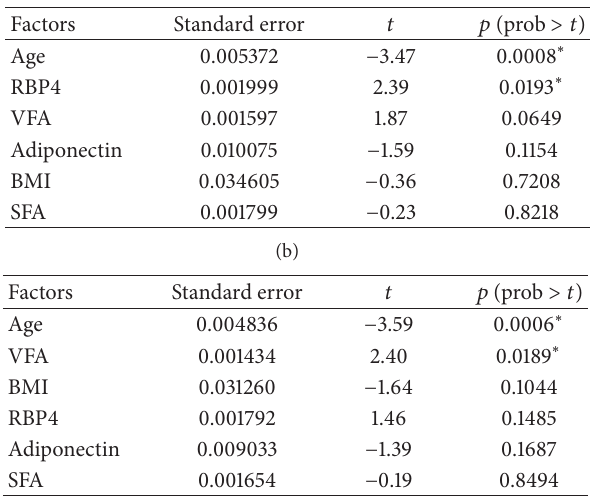
Table 3: (a) Multiple regression analysis with RLP-TG as a depen- dent variable and (b) Multiple regression analysis with TG as a dependent